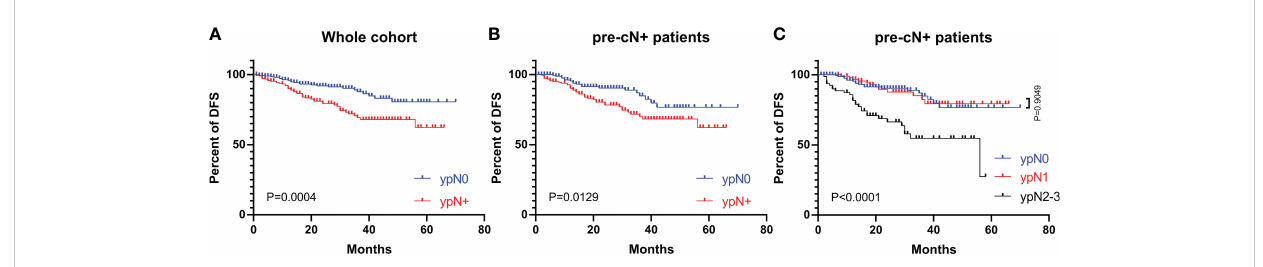
FIGURE 2 The DFS in patients with different ypN stages from the whole cohort and pre-cN+ groups. (A) The DFS of patients with ypN0 and ypN+ stages from the whole cohort (n=486); (B) The DFS of patients with pre-cN+/ypN0 and pre-cN+/ypN+ stages (n=366); (C) The DFS of patients with ypN0, ypN1 and ypN2-3 stages from pre-cN+ group (n=366).